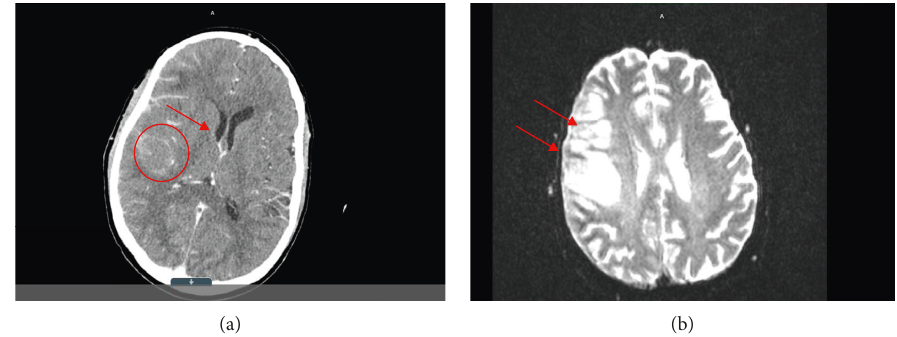
Figure 1: (a) Initial CT scan showing increased diffuse enhancement of right cerebrum as well as ill-defined hypodensity in the posterior right frontal lobe (circle). Slight mass effect is shown upon right lateral ventricle with edema (arrow). (b) MRI brain with gadolinium showing parenchymal and leptomeningeal enhancement over the right frontal and temporal lobes with associated T2/FLAIR signal in- volving right frontal lobe cortex (arrows), finding suggestive of meningoencephalitis.